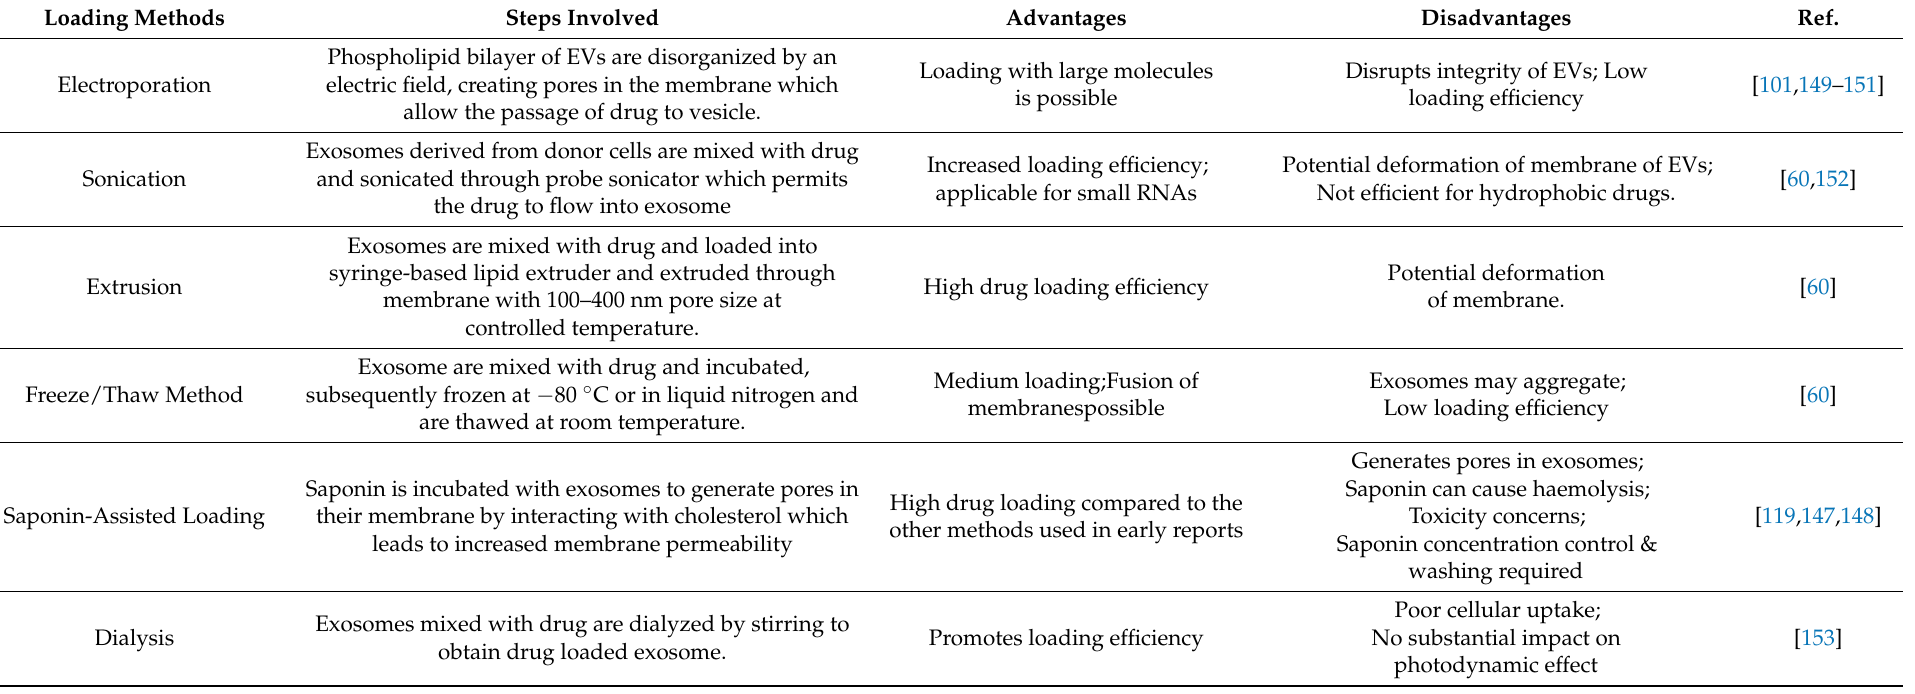
Table 2. Different techniques for loading cargos in EVs with advantages and